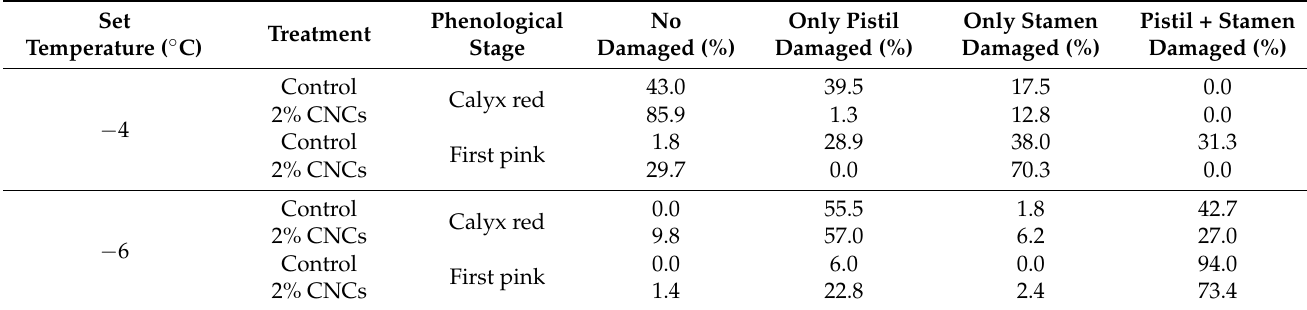
Table 1. Damage z to the flower buds of 2-year-old potted ‘Daewol’ peach trees caused by spring frost simulation (target temperatures: − 4 ◦ C or − 6 ◦ C) in SFDS